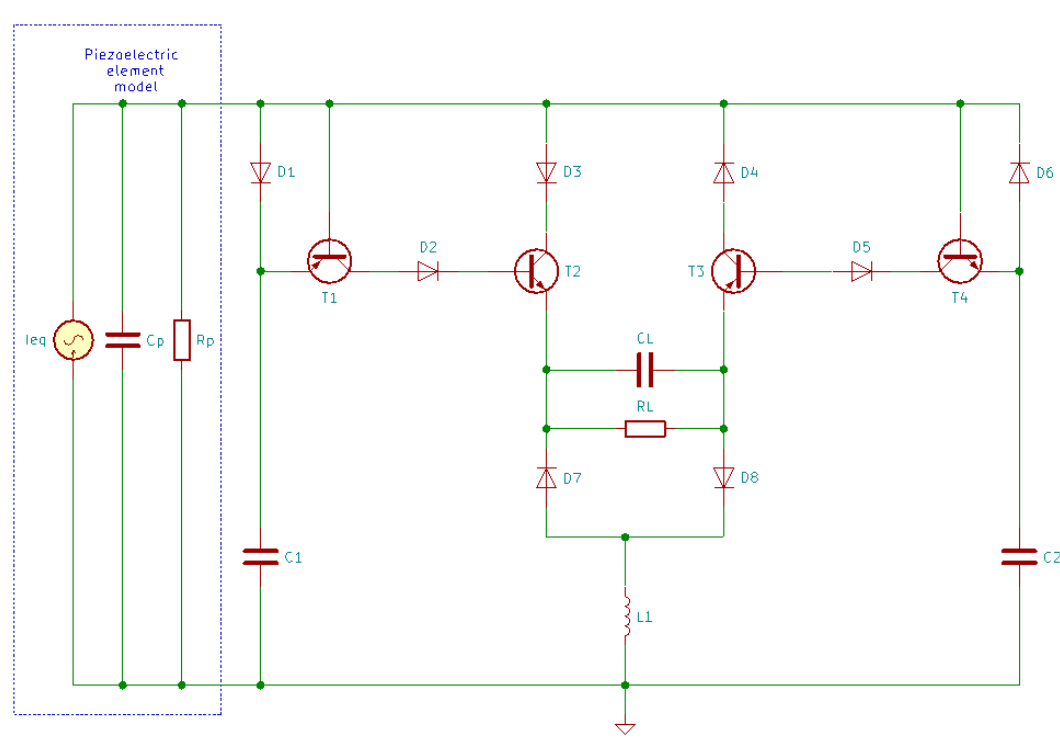
Figure 21. Self-powered parallel-SSHI energy harvesting circuit.